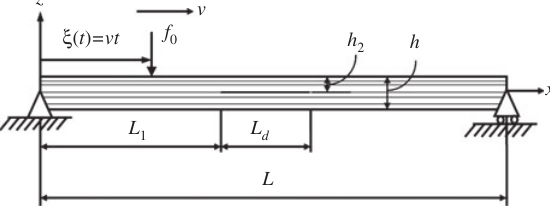
Figure 1 Delaminated composite beam traversed by a moving